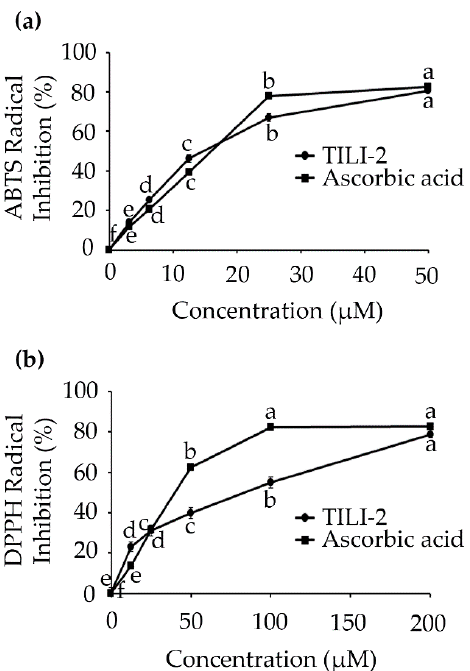
Figure 3. TILI-2 displays an antioxidant activity. ( a ) ABTS and ( b ) DPPH radical scavenging activities of TILI-2 and positive control ascorbic acid at concentrations ranging from 0 to 200 µ M for DPPH radical and 0 to 50 µ M for ABTS radical. All values represent the mean ± SD. Different letters indicate the significant differences from Duncan’s test ( p < 0.05).